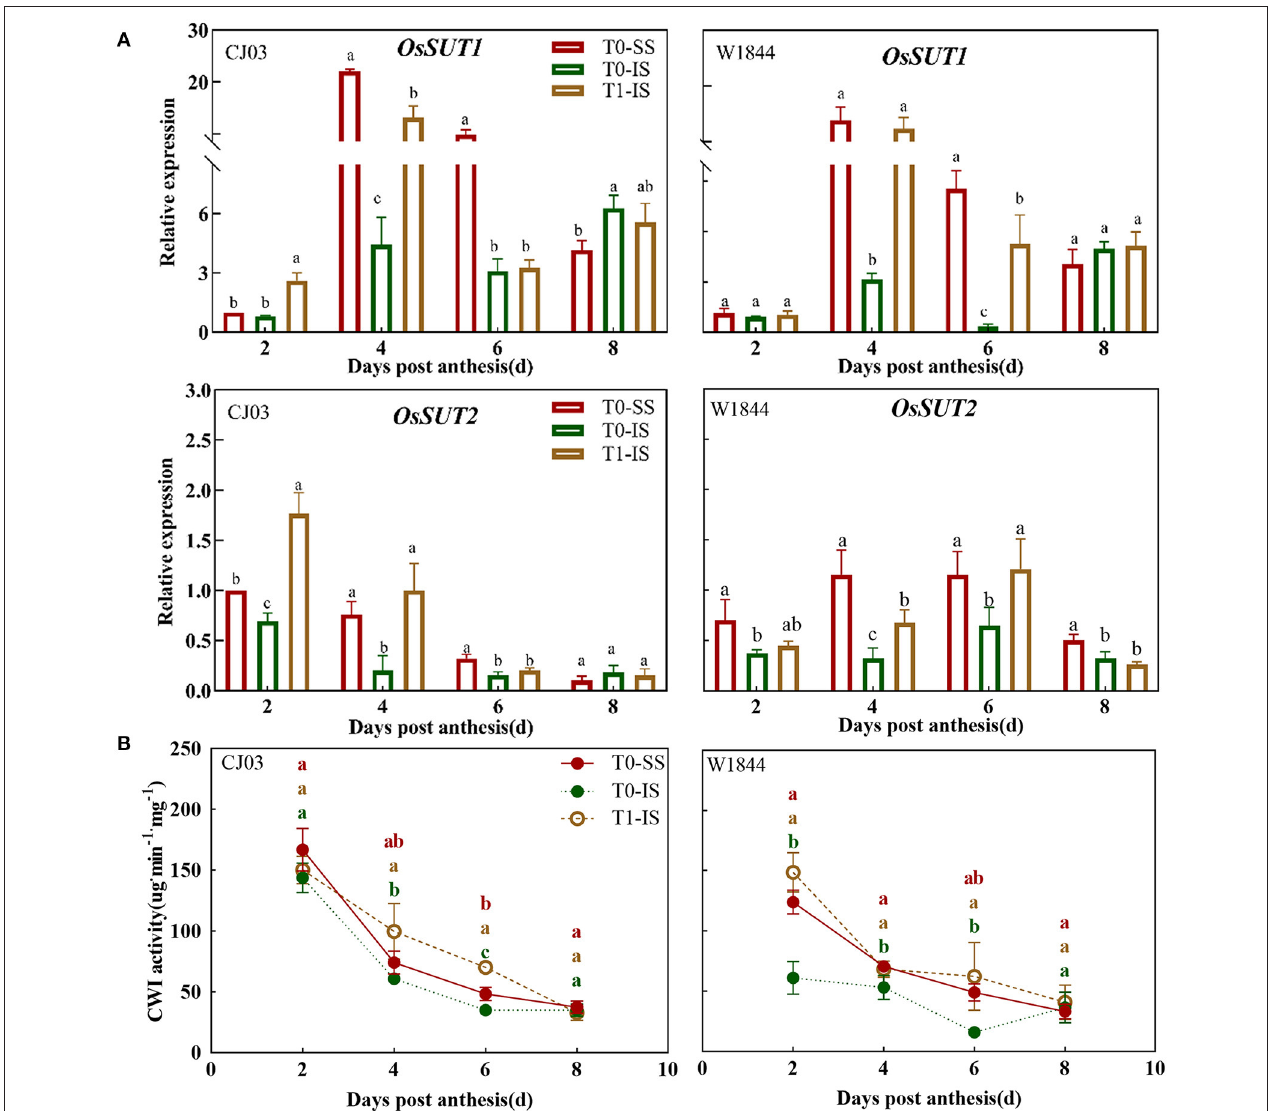
FIGURE 6 | Effects of the conversion of sucrose-unloading in developing grains of CJ03 and W1844 under spikelet-removing treatment. The T0-control group without any treatment; T1- top 2/3 of the spikelets were removed. Red, green, and yellow bars represent the SS of the T0 group, the IS of the T0 group, and the IS of the T1 group. (A) , the expression of OsSUTs genes was validated by RT-PCR. (B) , the CWI activity in SS and IS at the initiation of grain filling period. Colored letters indicate statistically significant differences at the P = 0.05